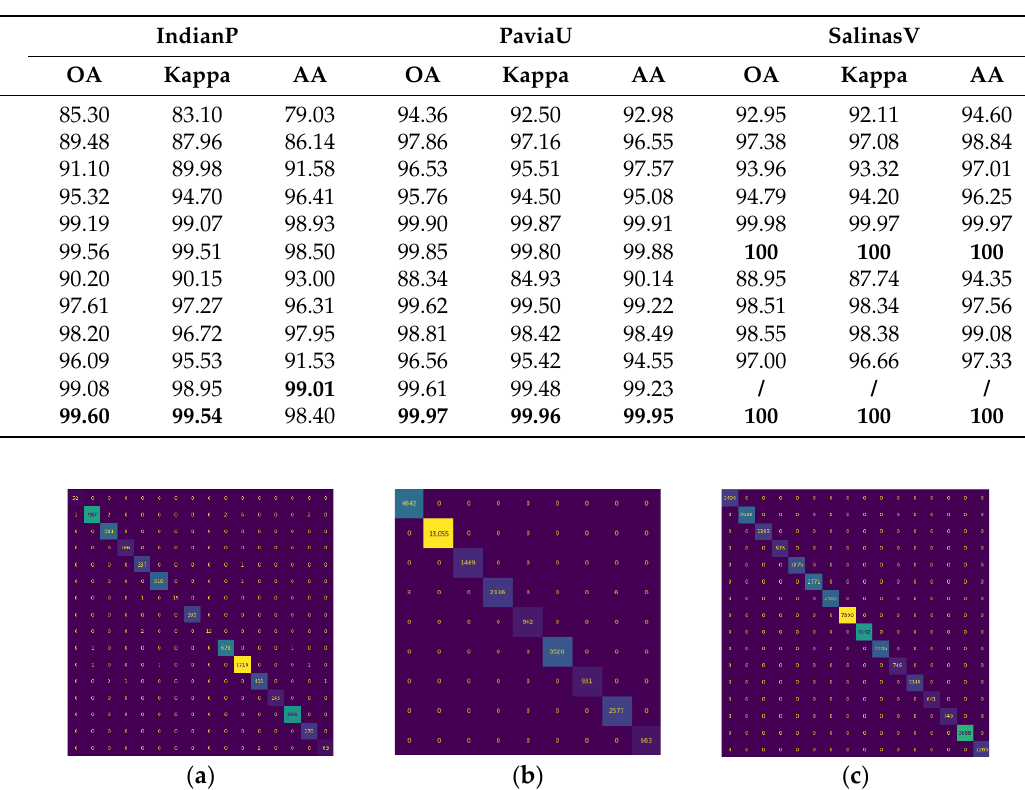
Figure 4. The confusion matrix obtained using the proposed method by using the IndianP, PaviaU, and SalinasV datasets in the first, second, and third matrices, respectively.